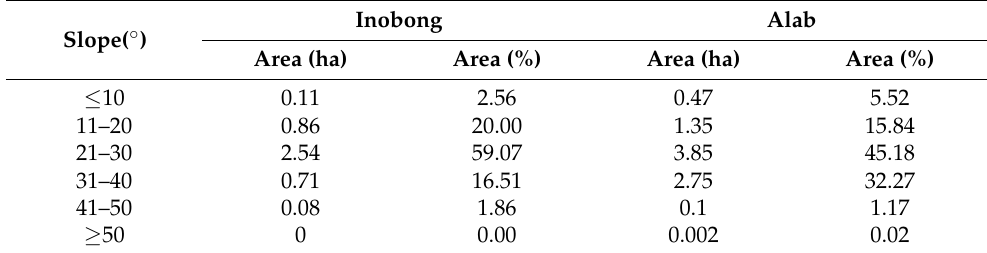
Table 1. Proportion of slopes in the TMCF and the TLRF.